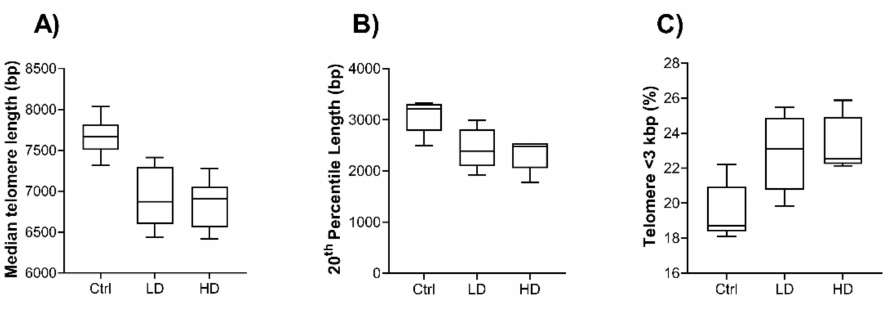
Figure 4. Effects of TiO 2 exposure on telomere length. Telomere length was measured after 13 weeks of exposure by high-throughput Q-FISH. ( A ) Median telomere length measured in base pairs (bp). ( B ) Twentieth percentile telomere length measured in bp. ( C ) Percentage of telomeres with a length <3kbp. Control (Ctrl), low dose (LD): 0.96 µ g/cm 2 and high dose (HD): 1.92 µ g/cm 2 . Box plots indicate median and 5–95 percentile ( n =